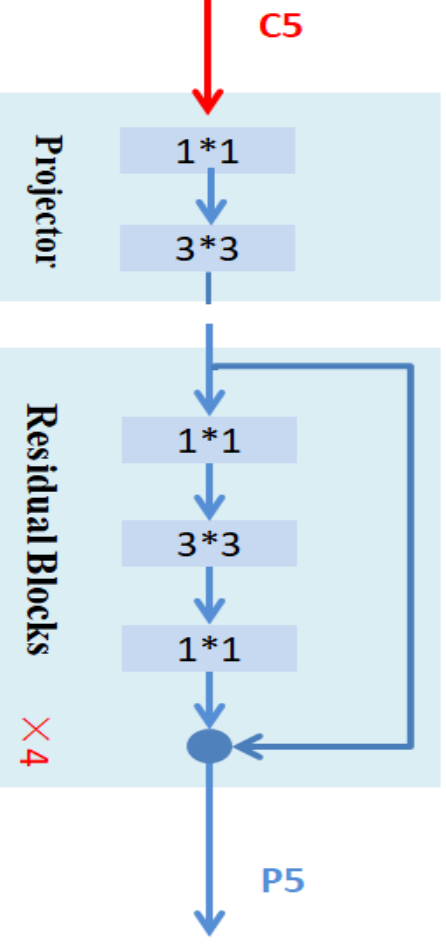
Figure 2. Encoder of YOLOF.